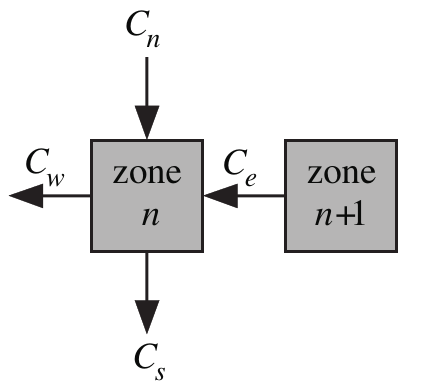
Figure 4. Data dependencies of two adjacent equitemporal zones from Figure 3. The north and east inputs to zone i are available at times n and n + 1, respectively. However, we notice that input C n only affects the west output C w and C e only affects the south output C s . Hence, at time n output C w is valid while output C s is not valid